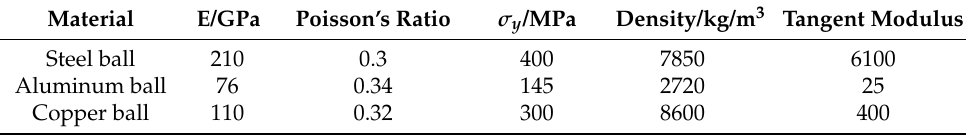
Table 2. Material